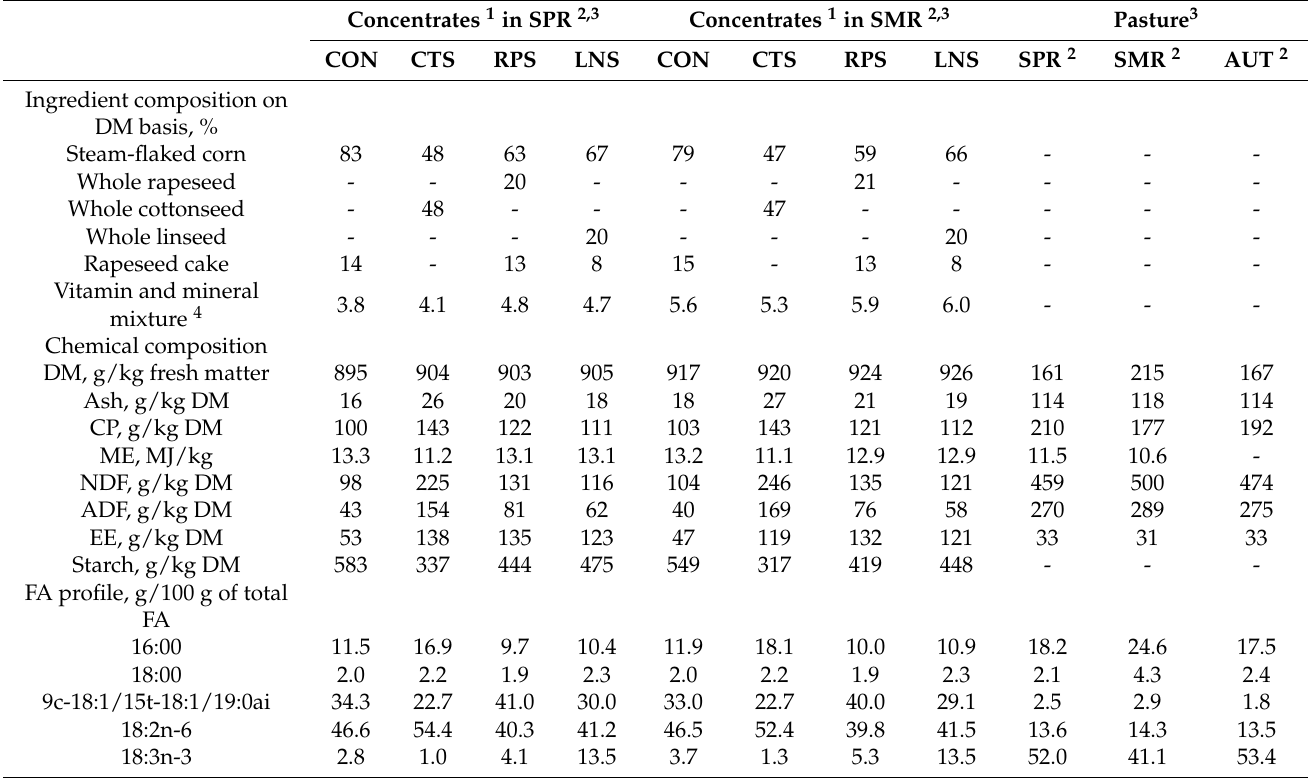
Table 1. Concentrate ingredient and chemical composition and major fatty acids (FA) content in concentrates and pasture in spring, summer and autumn seasons.